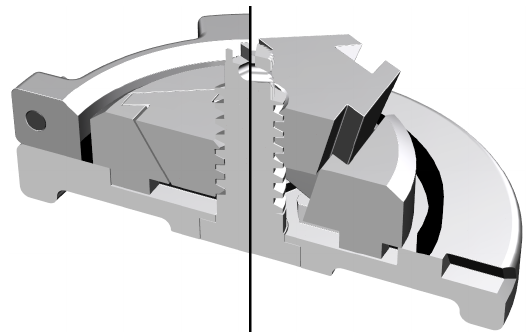
Figure 3. Mold in section view - left side with closed outer parts and centerpiece, right side with removed outer parts and collapsed center part.